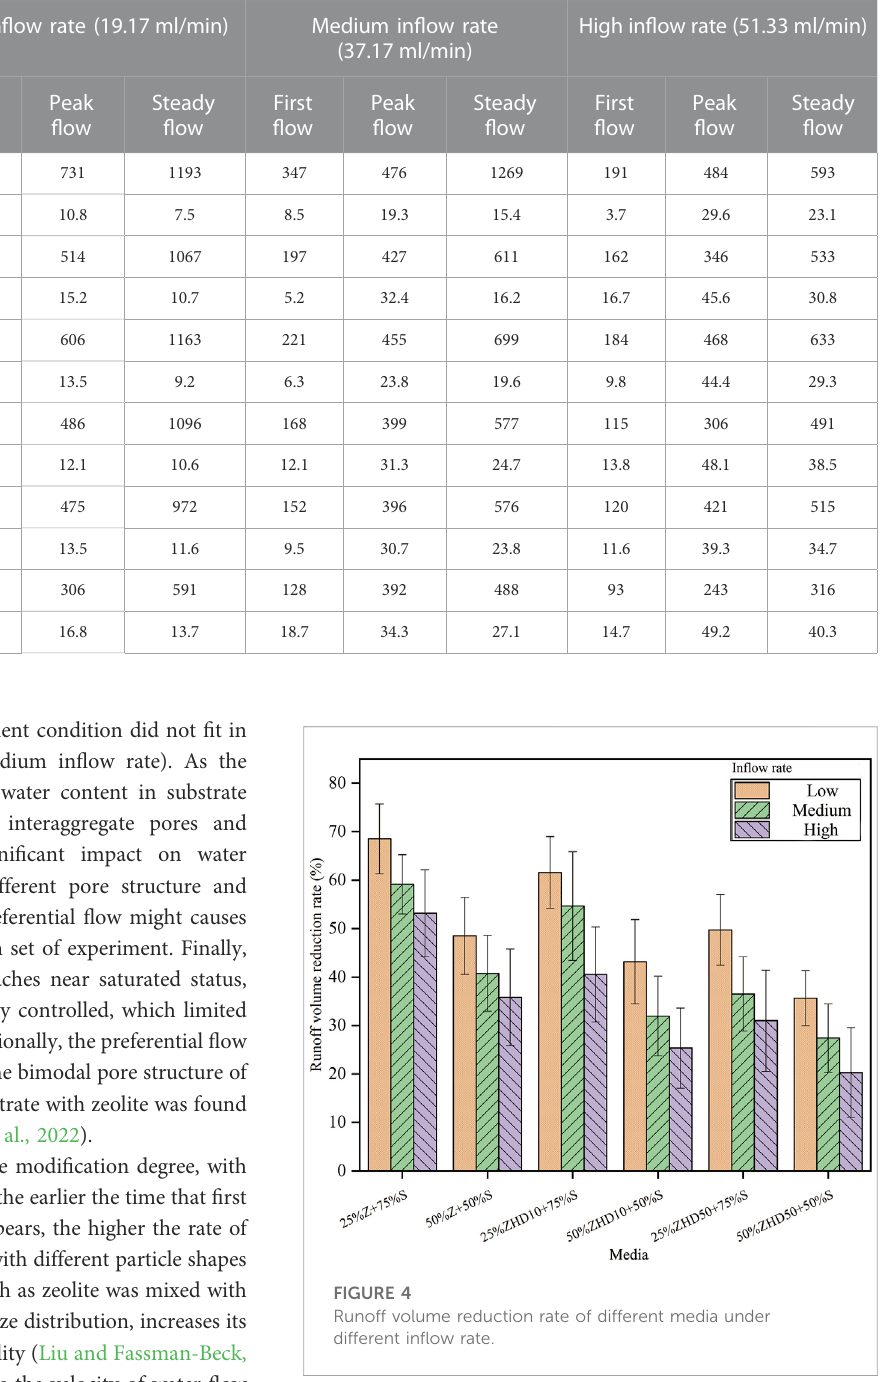
TABLE 2 Time of occurrence and fl ow rate for fi rst fl ow, peak fl ow, and steady fl ow of different media under different in fl ow rates.